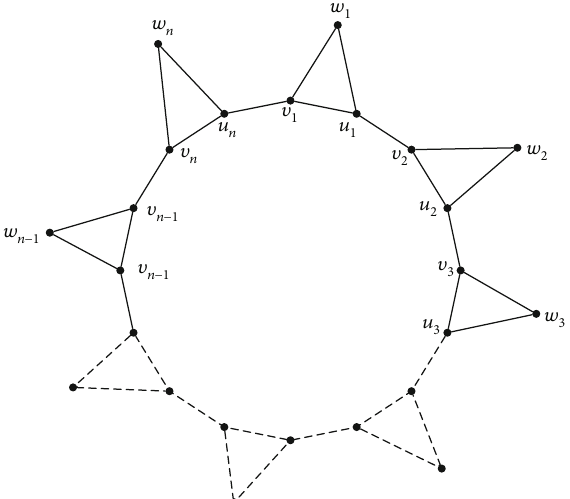
2 n Þ with edge ordinary